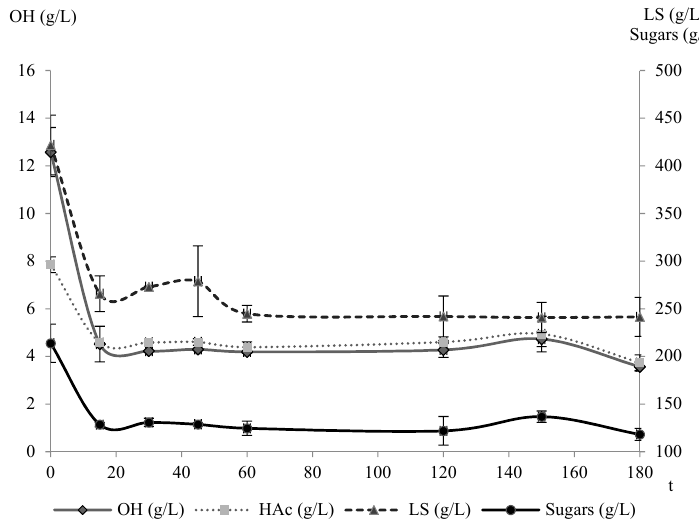
Figure 3. Concentration of sugars and inhibitors over time, using BC at 50 °C and 1:10 w / v ratio.